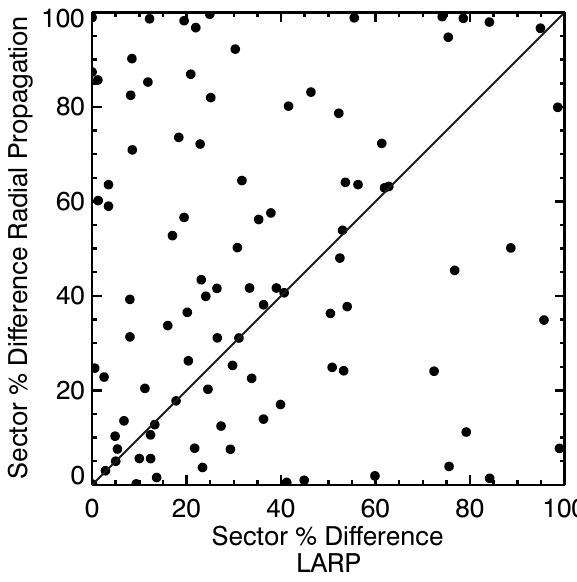
Fig. 7. Percent difference between the amount of inward sector for the model and data intervals. The x -axis uses intervals determined using the radial propagation and the source longitude adjustment. The y -axis is only using the radial propagation.